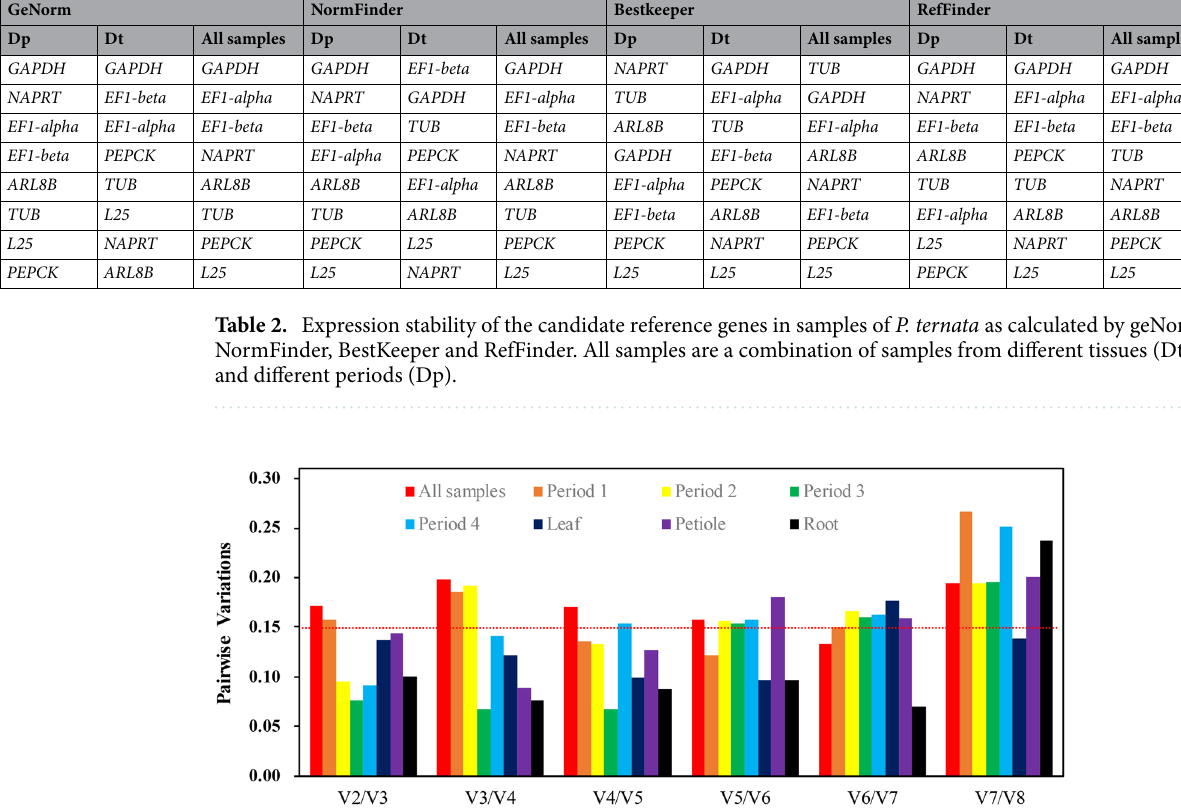
Figure 7. GeNorm calculated the minimum number of reference genes necessary for reliable and accurate normalization. Determination of the optimal number of reference genes for qRT-PCR normalization in all samples, different tissues and different